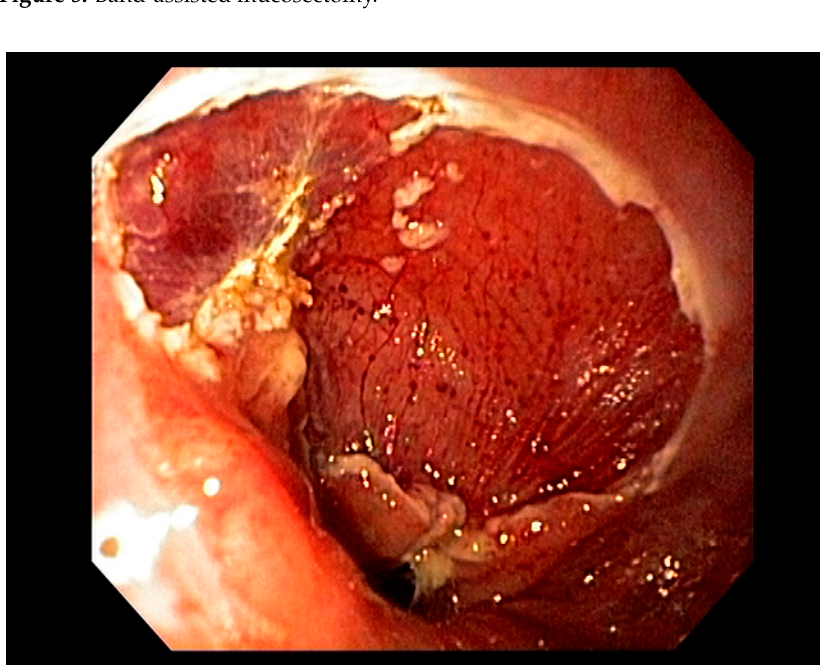
Figure 6. Endoscopic Mucosal Rejection (EMR) T1 esophageal cancer; resection site.